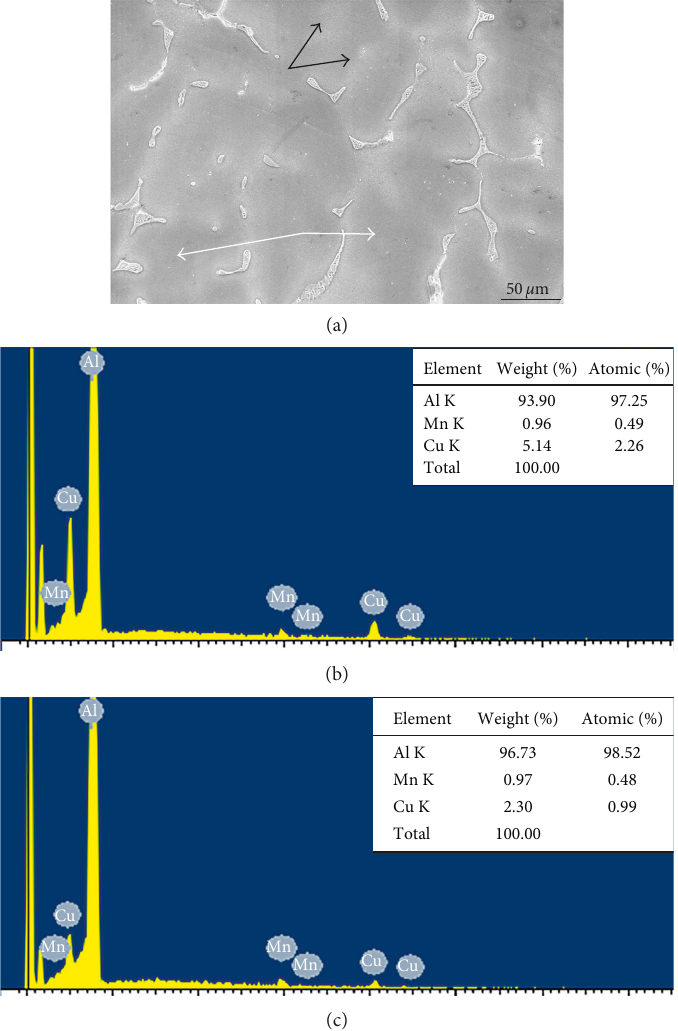
Figure 6: SEM image showing the light-grey and dark-grey areas of dendrites in the A area (b) and dark-grey area (c).